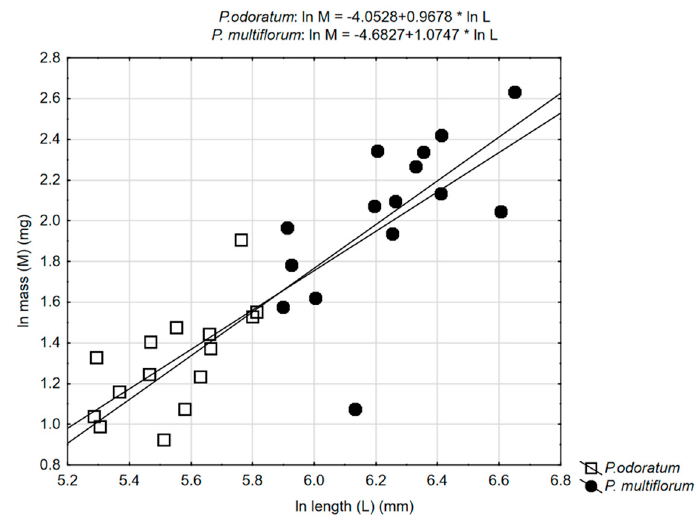
Figure 6. Relationships between mass and length of the shoot for the two species P. odoratum and P. multiflorum.